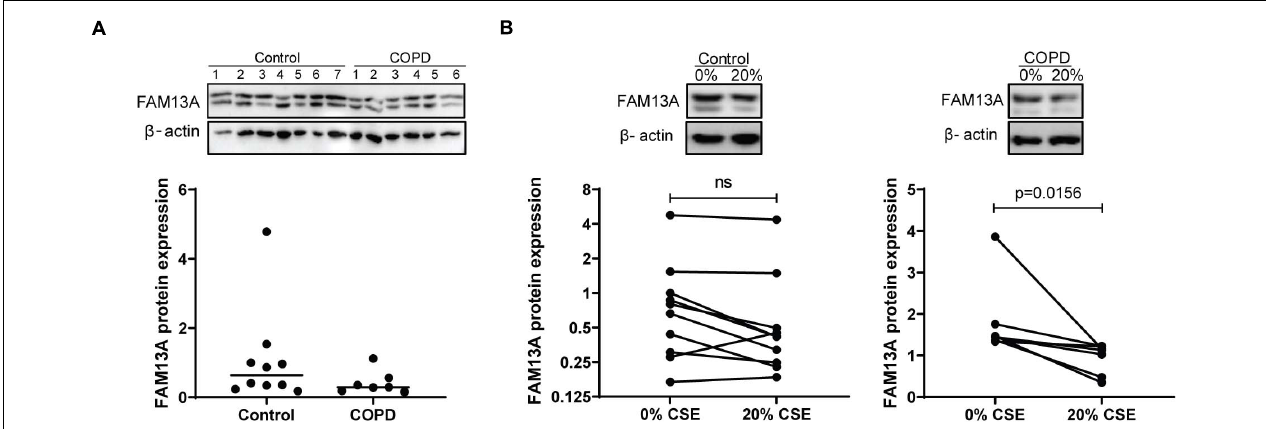
FIGURE 2 | FAM13A expression in primary human airway epithelial cells. (A) Control and COPD-derived AECs were seeded in duplicate, grown to confluence, and incubated with hormone-free media for 24 h. FAM13A levels were detected by western blot in total cell lysates, quantified by densitometry and normalized to β -actin as the loading control. Medians are indicated, control n = 10, COPD n = 7. A representative blot is shown. Significant differences were assessed by the Mann-Whitney test. (B) Control and COPD-derived AECs were cultured and hormonally deprived as described above, and incubated with or without 20% cigarette smoke extract (CSE) for 24 h. FAM13A levels were detected and quantified as for panel A. Each dot represents one subject, control n = 10, COPD n = 7. Representative blots are shown. Significant differences were assessed by the Wilcoxon signed rank test and p -value is indicated.